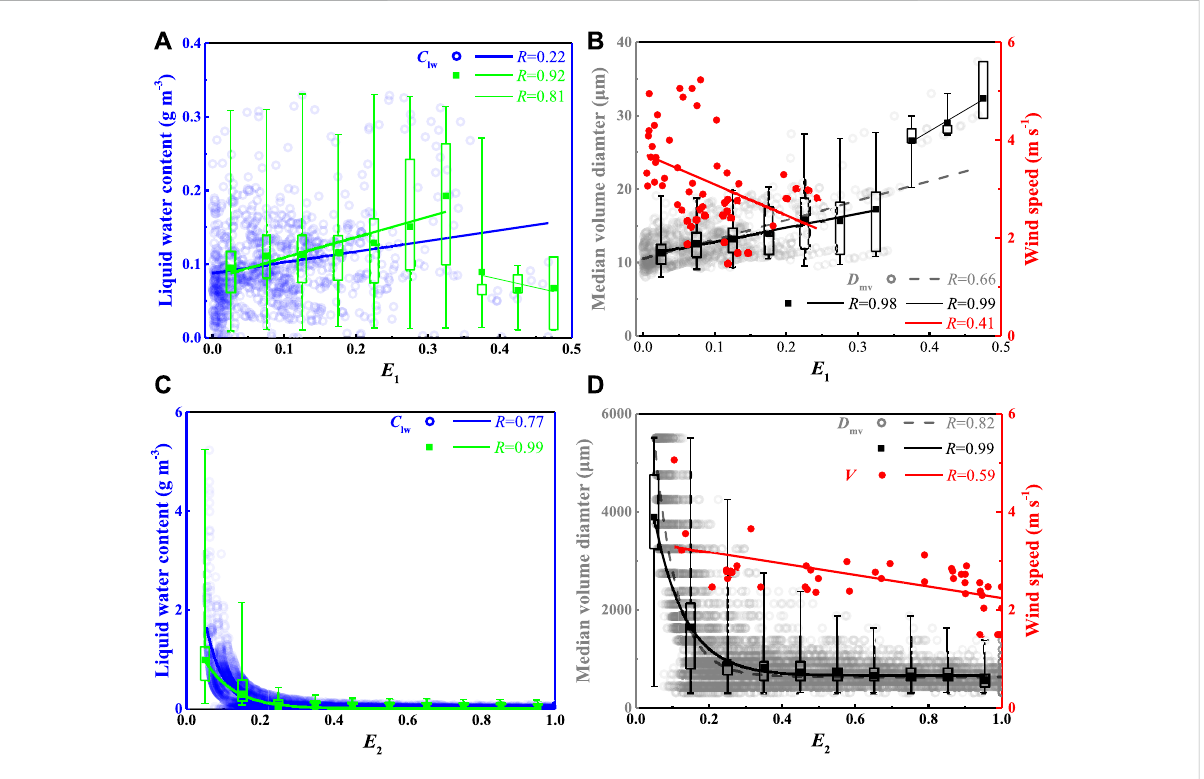
FIGURE 5 Scatter plots comparing collision rate E1 with liquid water content Clw (A) , median volume diameter Dmv, and wind speed V (B) during SF process, and freezing rate E2 with liquid water content Clw (C) , median volume diameter Dmv, and wind speed V (D) during FR process. The corresponding least-square fi tting lines and correlation coef fi cient (R) are given in the corner of each panel. Box plots also show (A) Clw, (B) Dmv of SF process, and (C) Clw, (D) Dmv of FR process with the E1 intervals of the value of 0.05, and the E2 intervals of the value of 0.1. The central box represents the values from the lower to upper quartiles (25th to 75th percentiles), and the vertical line extends from the minimum to the maximum. The middle solid square represents the mean